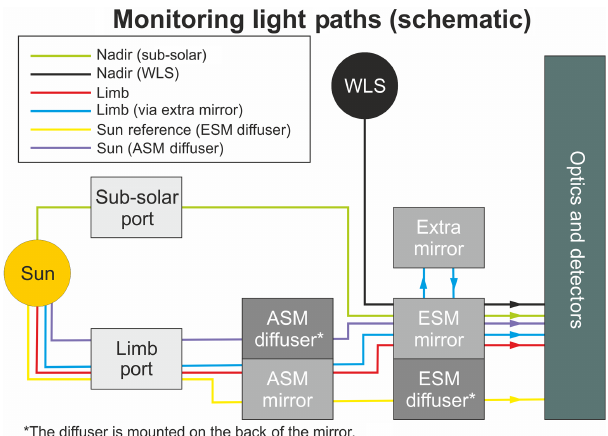
Figure 1. Schematic diagram of SCIAMACHY’s scanner unit with all light paths relevant for the recalibration of the solar spectra. The nadir light path provides solar measurements via the sub-solar port and ESM mirror, the limb light path solar measurements via the limb port and both scan mirrors. There is also the option of using an extra mirror in this light path. The nominal solar reference mea- surements (Sun reference, absolute radiometrically calibrated) use the ESM diffuser and the ASM mirror as light path. Solar measure- ments via the ASM diffuser and the ESM mirror are also possible. In-flight monitoring and wavelength calibration are done using the WLS and the spectral line source (SLS, not shown),